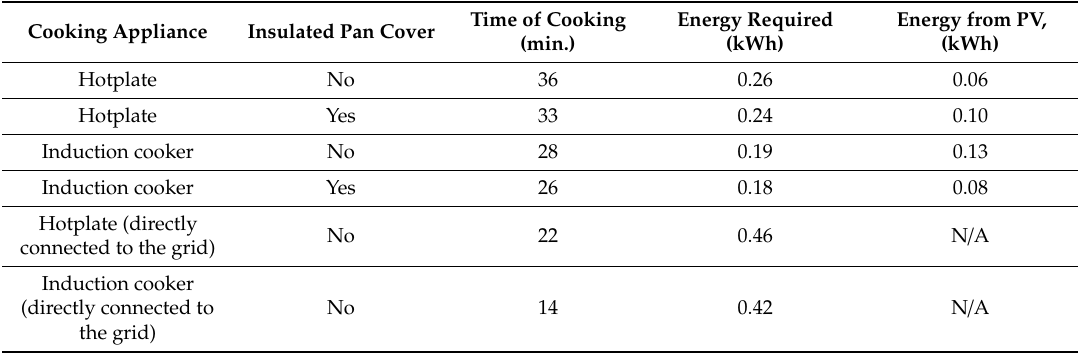
Table 4. Rice cooking energy data using hotplate and induction cooker; 0.5 kg of rice was cooked by adding 1 L of water.